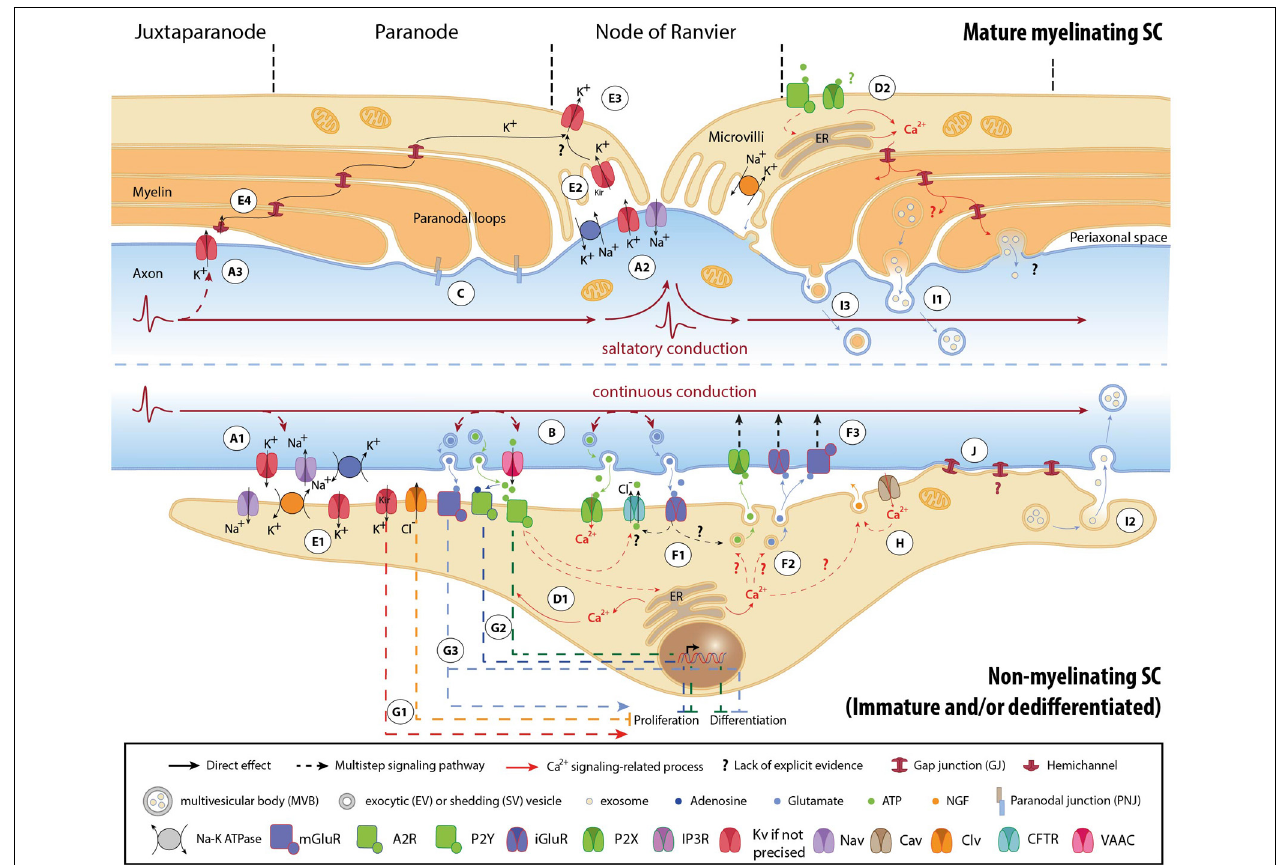
FIGURE 1 | Mechanisms involved in activity-dependent axon-Schwann cell bilateral communication. Schematic representation of the different molecules and mechanisms described in myelinated (upper part) and non-myelinated (lower part) PNS fibers. (A) Ephaptic communication through ion flows across the plasmalemma of unmyelinated (A1) and myelinated axons (A2, A3) . (B) Paracrine signaling from axons to SCs. (C) Physical coupling between axons and mSCs. (D) SC Ca 2 + transients developing after neuronal stimulation. In nmSCs activation of purinergic receptors leads to increase of cytoplasmic Ca 2 + due to influx from the extracellular space, or efflux from intracellular stores (D1) (Stevens et